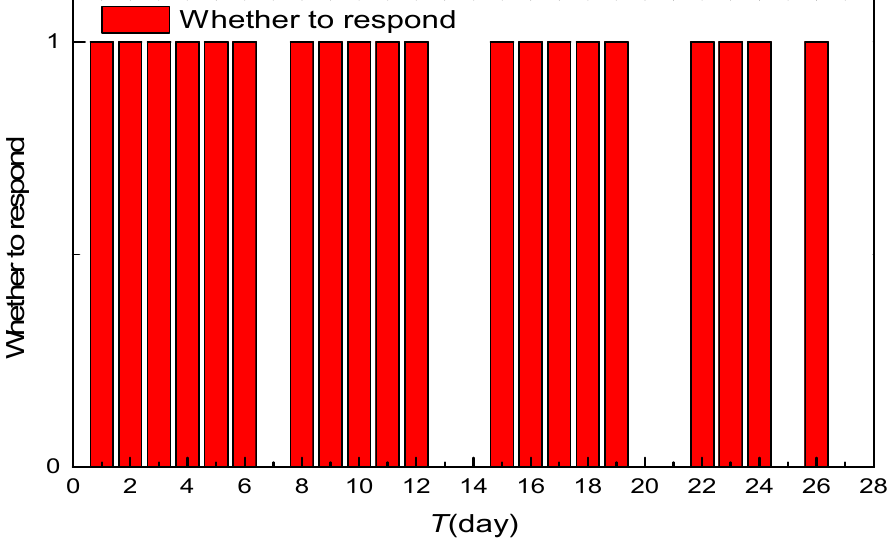
Figure 13. Short-term response of flexible load users.